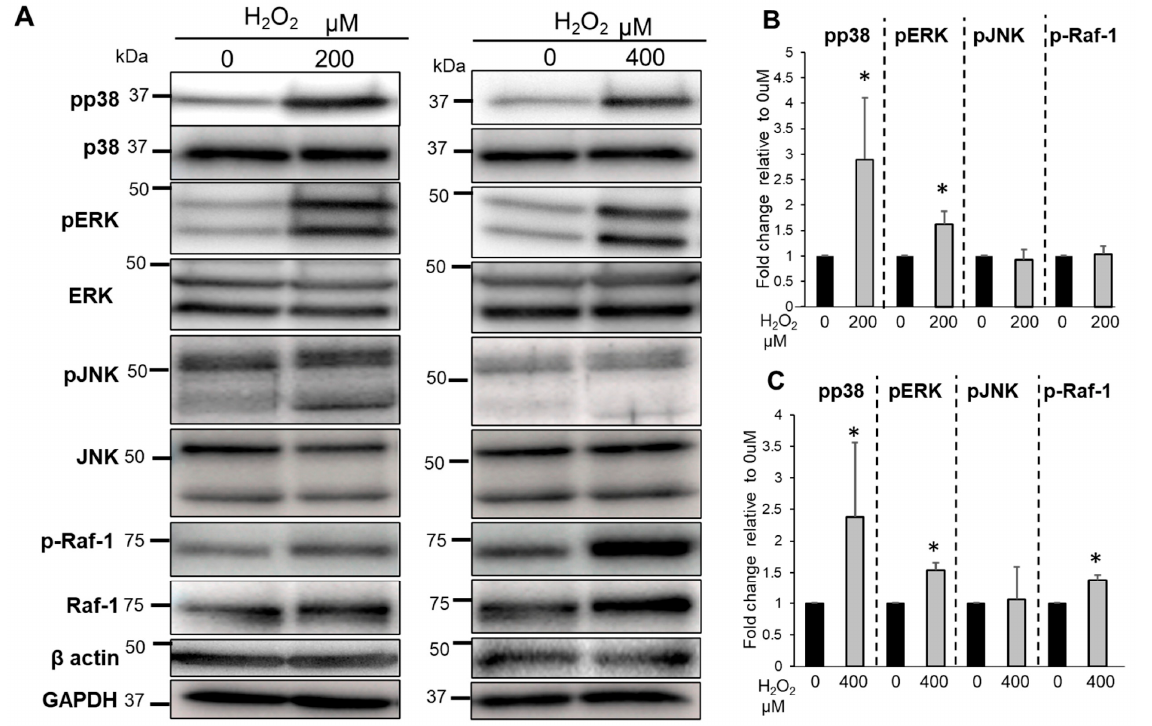
Figure 6. Evaluation of the phosphorylation of MAPK family members and Raf-1 in NP cells. Western blotting ( A ) and quantification ( B , C ) of the phosphorylated forms of p38, ERK, JNK, and Raf-1in NP cells treated with or without H 2 O 2 for 30 min. Data are the means ± SD n = 3, * p < 0.05. Similarly, in Bag-1-overexpressing cells, the phosphorylation of Raf-1 did not signif- icantly increase at 200 µ M H 2 O 2 but increased significantly at 400 µ M H 2 O 2 compared